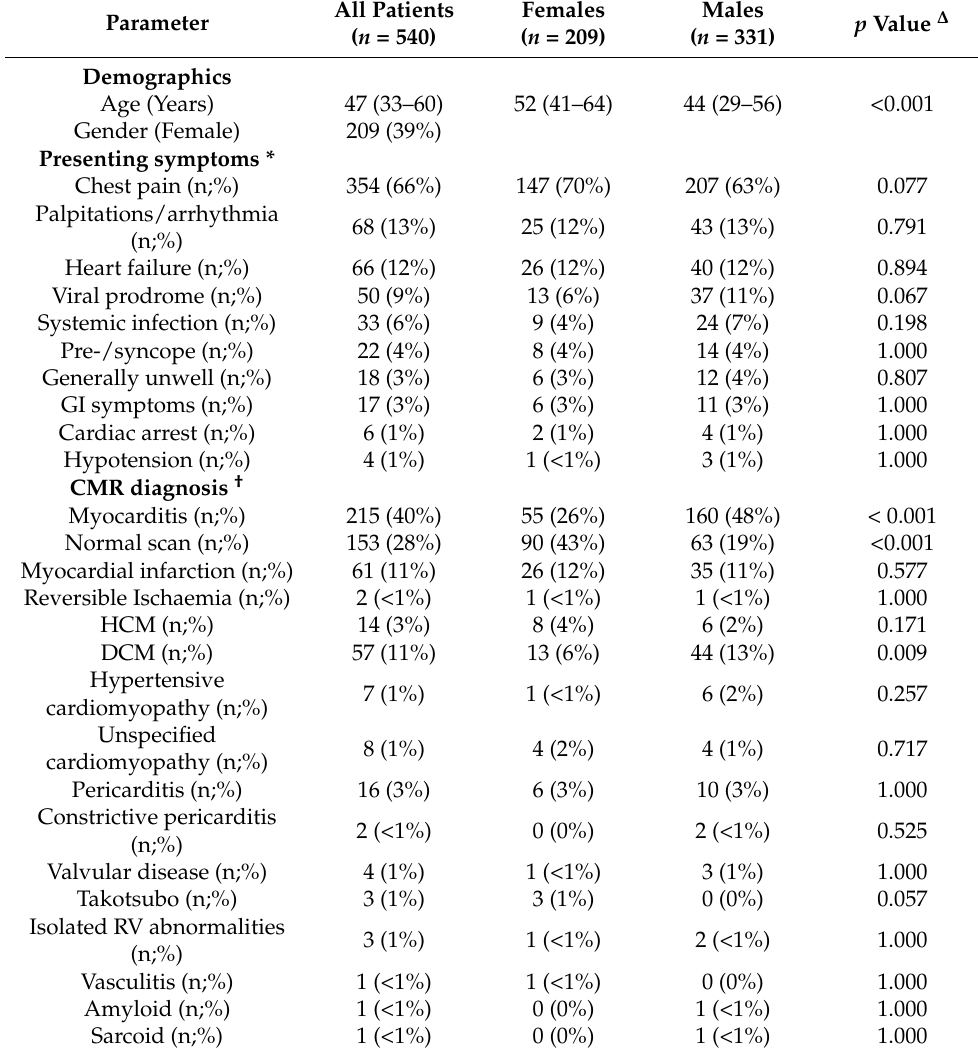
Table 1. Baseline